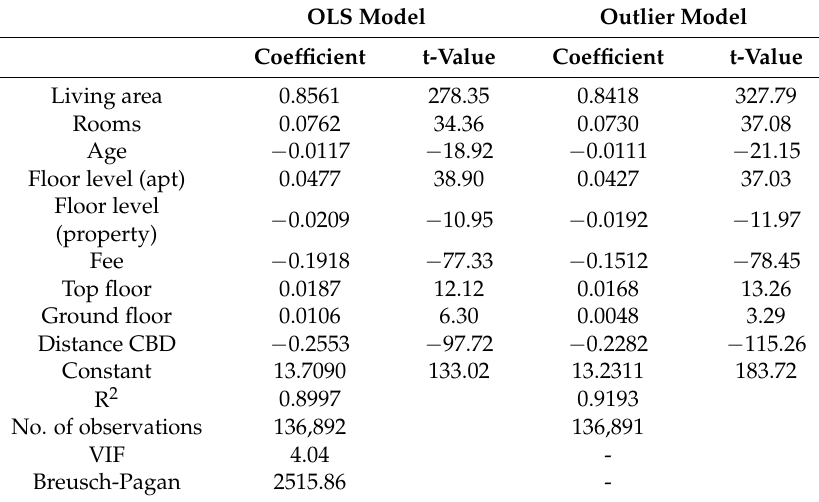
Table 2. The hedonic regression model (OLS and outlier